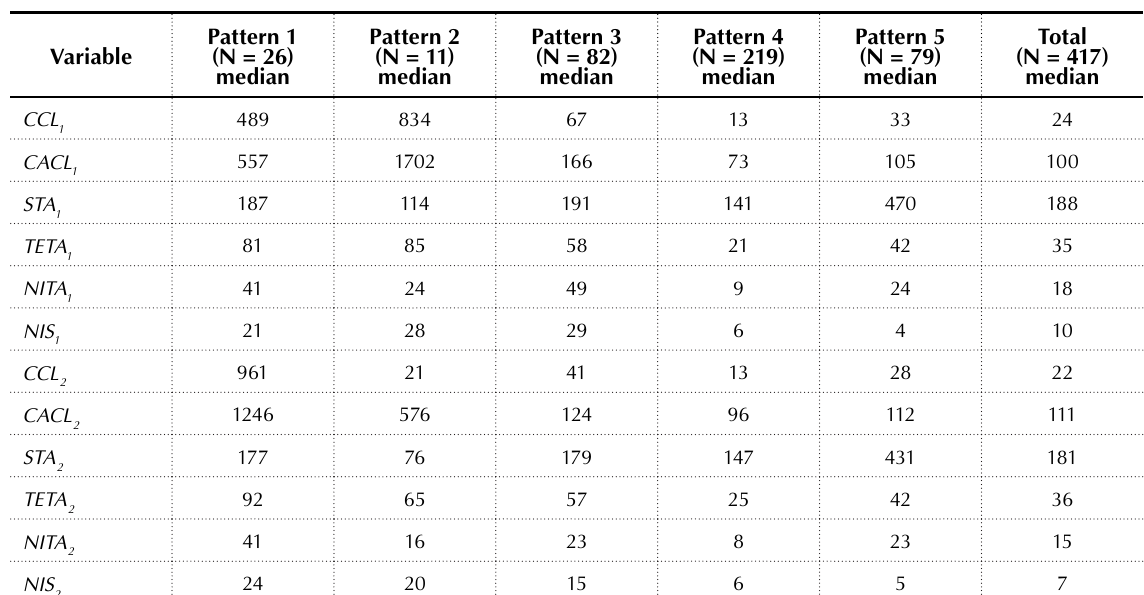
Table 5. Median values of financial ratios through five detected patterns, %